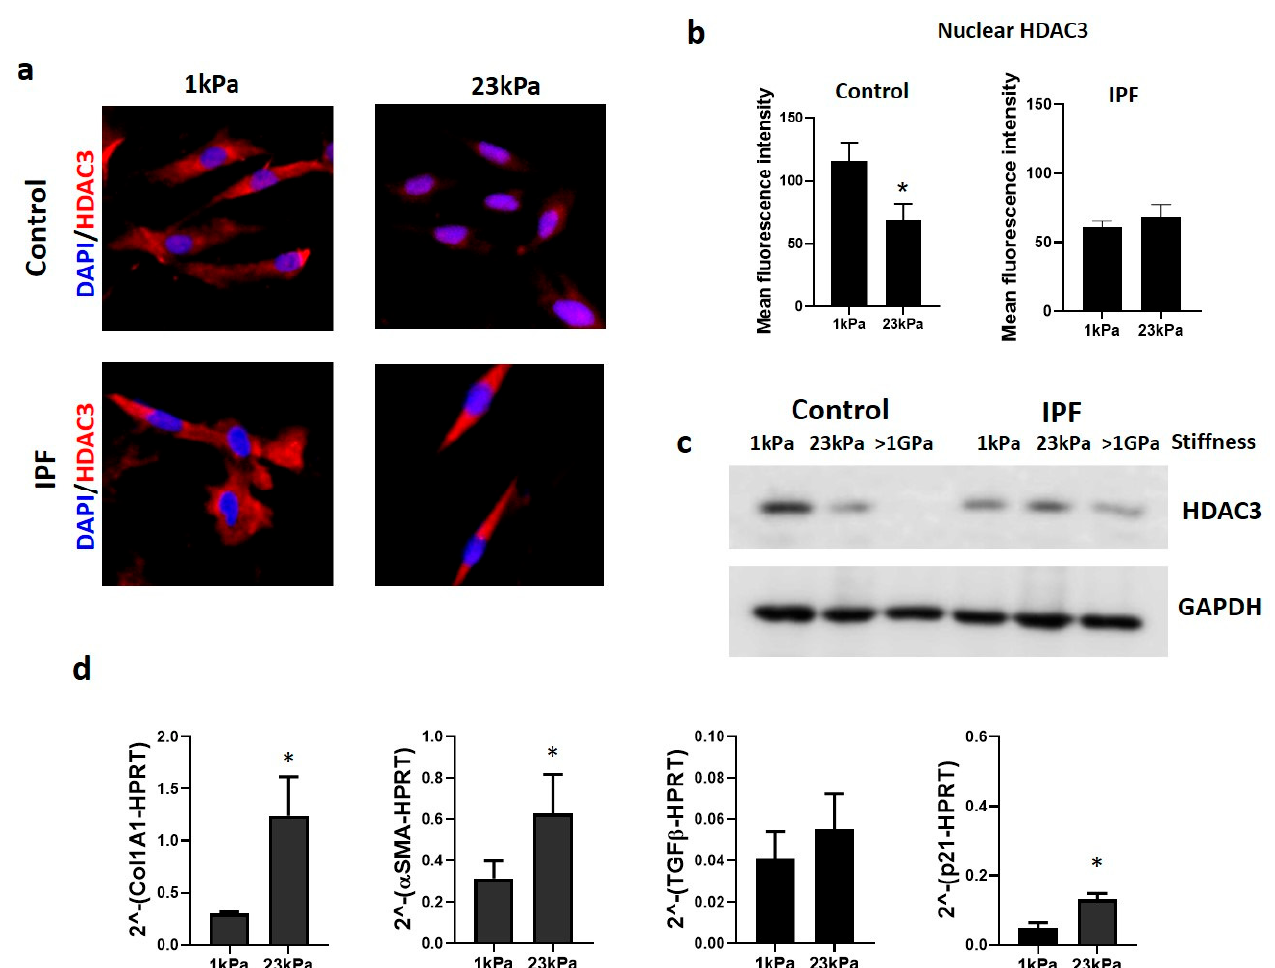
Figure 5. Matrix stiffness causes a decrease in HDAC3 in control fibroblasts and regulates the expression of profibrotic genes. ( a ) Representative immunostaining images of HDAC3 in control and IPF fibroblasts cultured on polyacrylamide hydrogels of 1 and 23 kPa; HDAC3 (red) and nuclei (blue). ( b ) A measure of mean fluorescence intensity of nuclear HDAC3 from three independent experiments; data presented as mean ± SD. * p < 0.05 by unpaired Student’s t -test. ( c ) Representative immunoblot of HDAC3 from fibroblast-cultured polyacrylamide hydrogels of 1, 23 kPa, and <1 GPa (culture plates) for five days. ( d ) qPCR analysis of fibrosis-related genes, Col1A1, α SMA, TGF β , and p21, which increase expression when cells are cultured on 23 kPa hydrogels. * p < 0.05; by unpaired Student’s t -test.